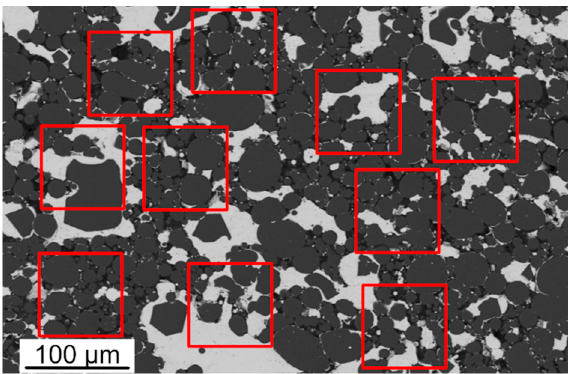
Figure 4. SEM micrograph of Al-10vol%Sn sample, sectioned on a plane parallel to the compression direction.